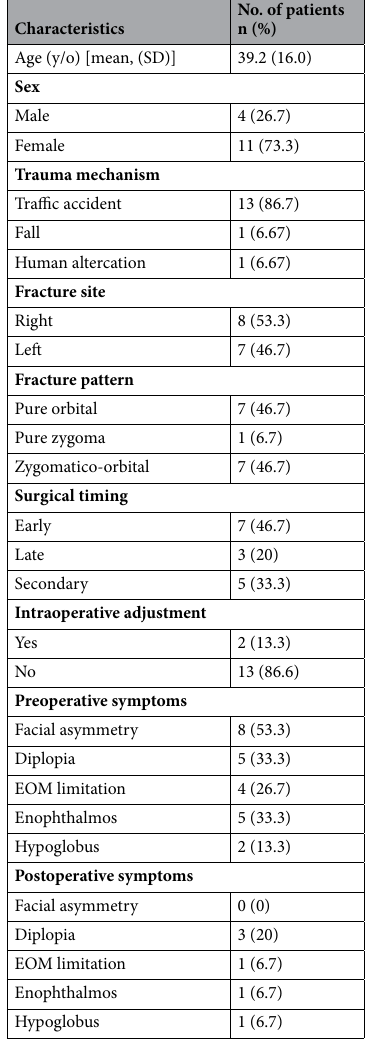
Table 1. Patient demographics. EOM extraocular muscle movement.